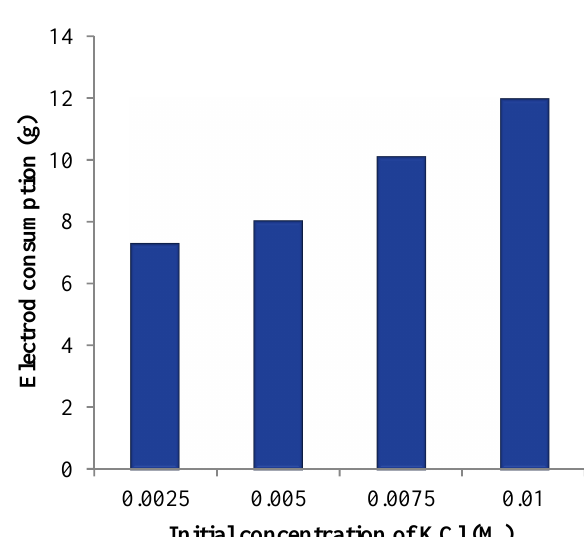
Figure 8. Effect of KCl concentration on electrode consumption (Voltage = 50 v, C 0 = 50 mg/l, d = 1 cm, pH =11, T= 22 ± 2 º C)